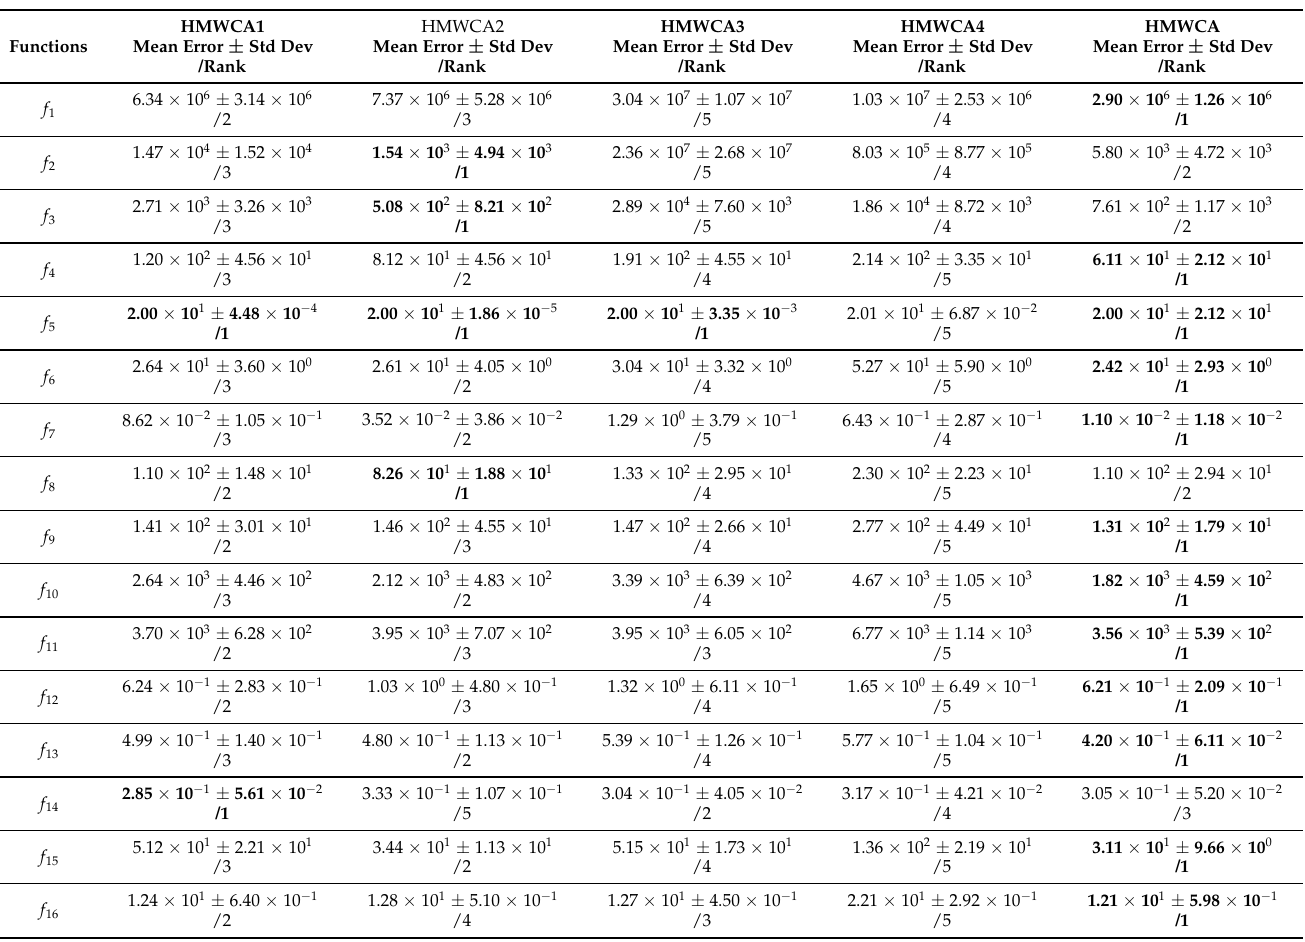
Table 2. Experimental results of the HMWCA and its four variants on the CEC 2014 functions with D =